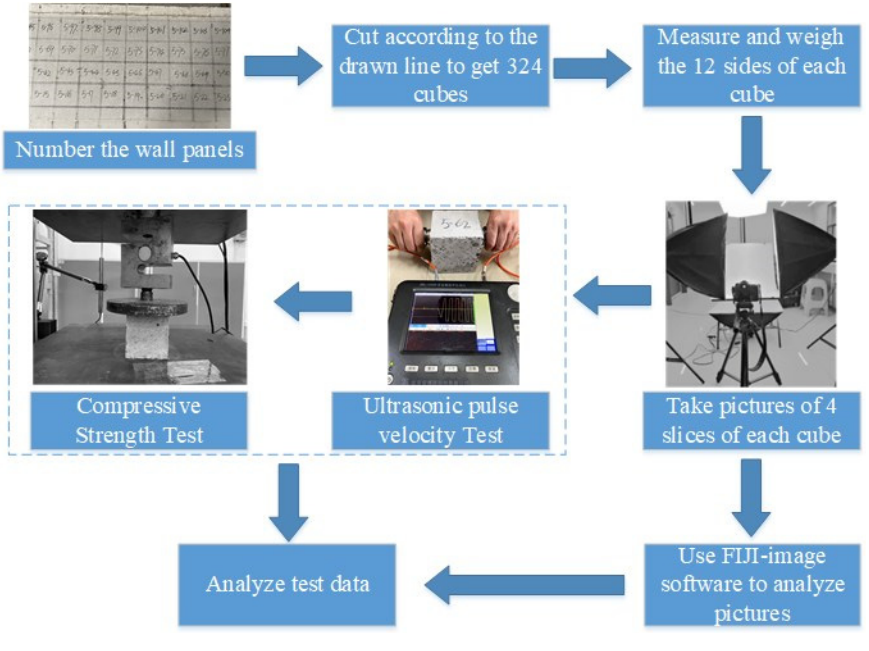
Figure 2. Test procedures.